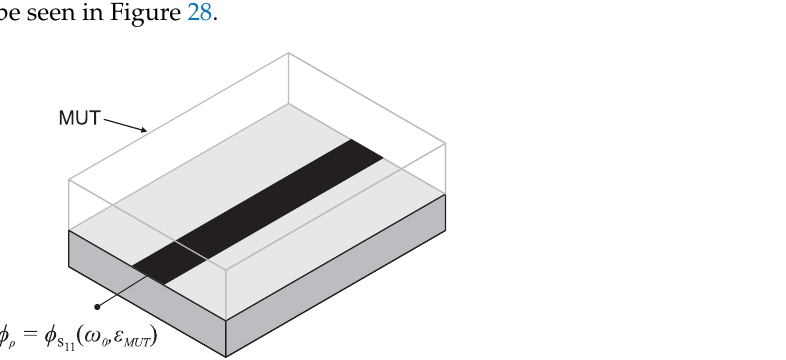
Figure 28. Sketch, in perspective view, of an open-ended sensing